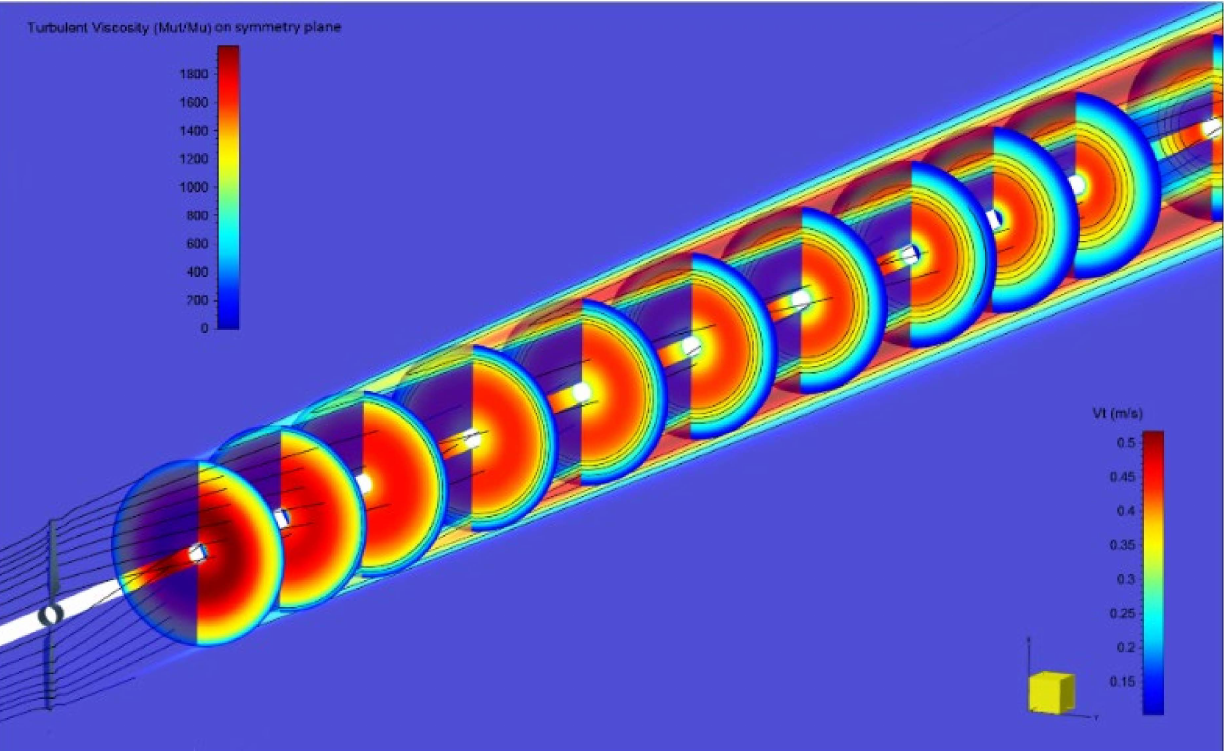
Figure 30. Velocity deficit downstream of the wind turbine rotor on cross planes and turbulent viscosity in symmetry plane. Second image shows tangential velocity downstream of rotor on cross planes and turbulent viscosity in symmetry